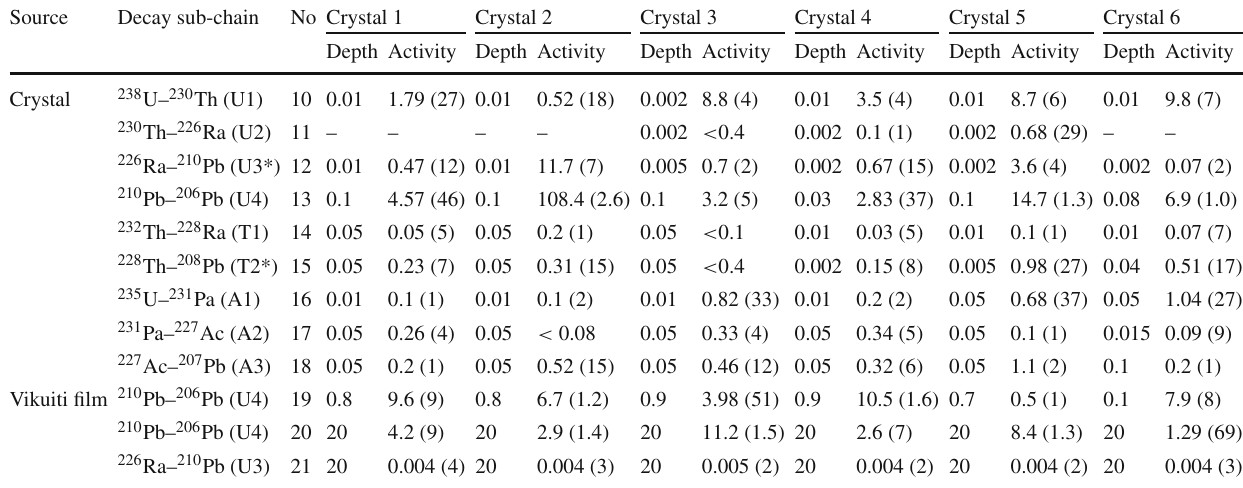
Table 5 Fitted activities of 232 Th, 235 U, and 238 U sub-chains in the surface layers of CMO crystal scintillators and reflecting film ( µ Bq/cm 2 ). Surface depths are in units of µ